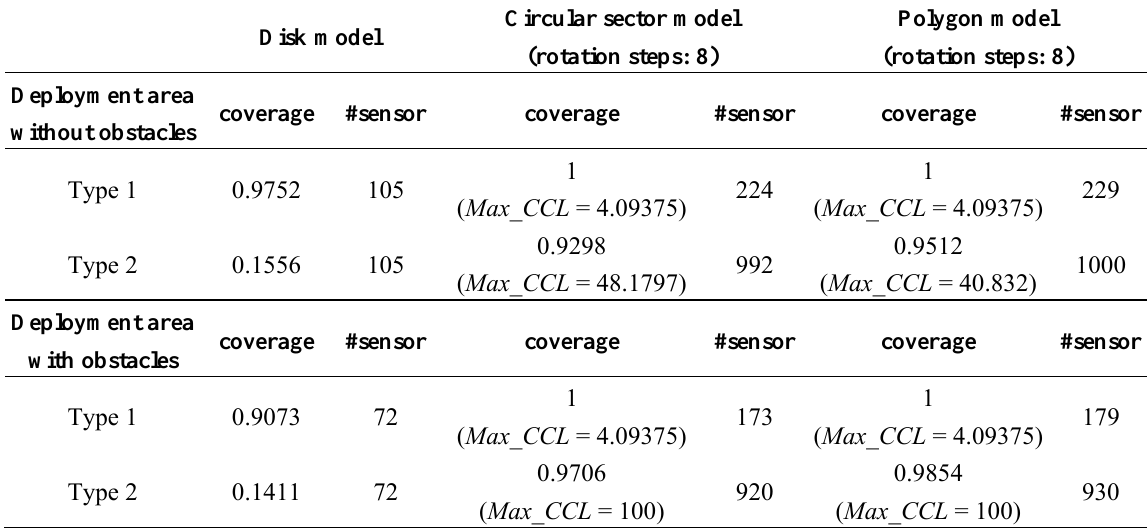
Table 4. The maximum sensing coverage rates and the usage of sensor nodes for each type in Case 1.